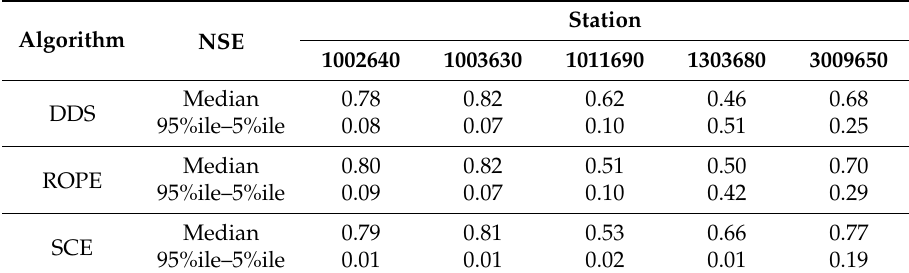
Table 3. Validation of calibrated parameters to di ff erent events and its performance measured by NSE values (median and variation from 100 simulations with di ff erent initial parameter